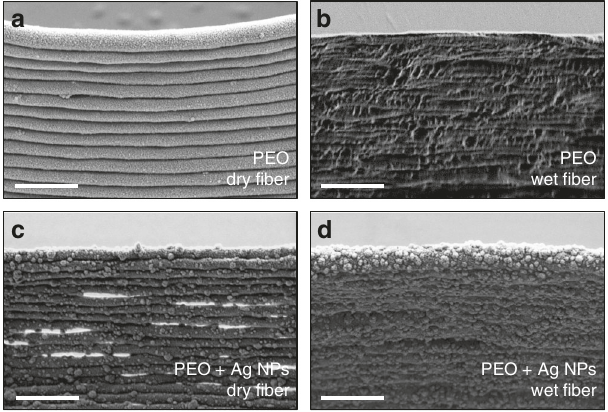
Fig. 6 Control of the wall microstructure. SEM micrograph showing the effect of jet wetness/viscosity upon arrival to the substrate on the microstructure of a printed wall: a PEO wall obtained by stacking dry- arriving fi ber layers, where the different PEO layers are clearly distinguishable. b Compact PEO wall obtained by stacking wet-arriving fi ber. c PEO-Ag wall produced from dry-arriving fi ber, where layers and pores between them are clearly visible. d Compact PEO-Ag wall produced from wet-arriving fi ber. All scale bars are 1 µ